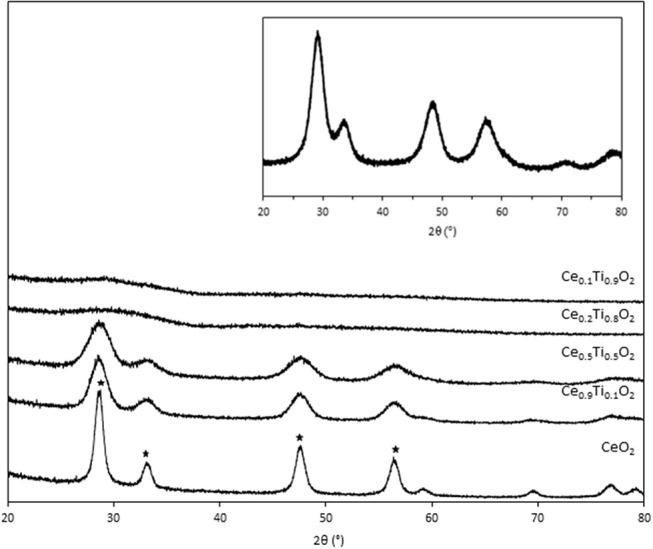
XRD stack of synthesized the CexTi1−xO2 materials, showing cubic fluorite reflection of CeO2 (*). Inset: XRD pattern of Ce0.5Zr0.5O2.